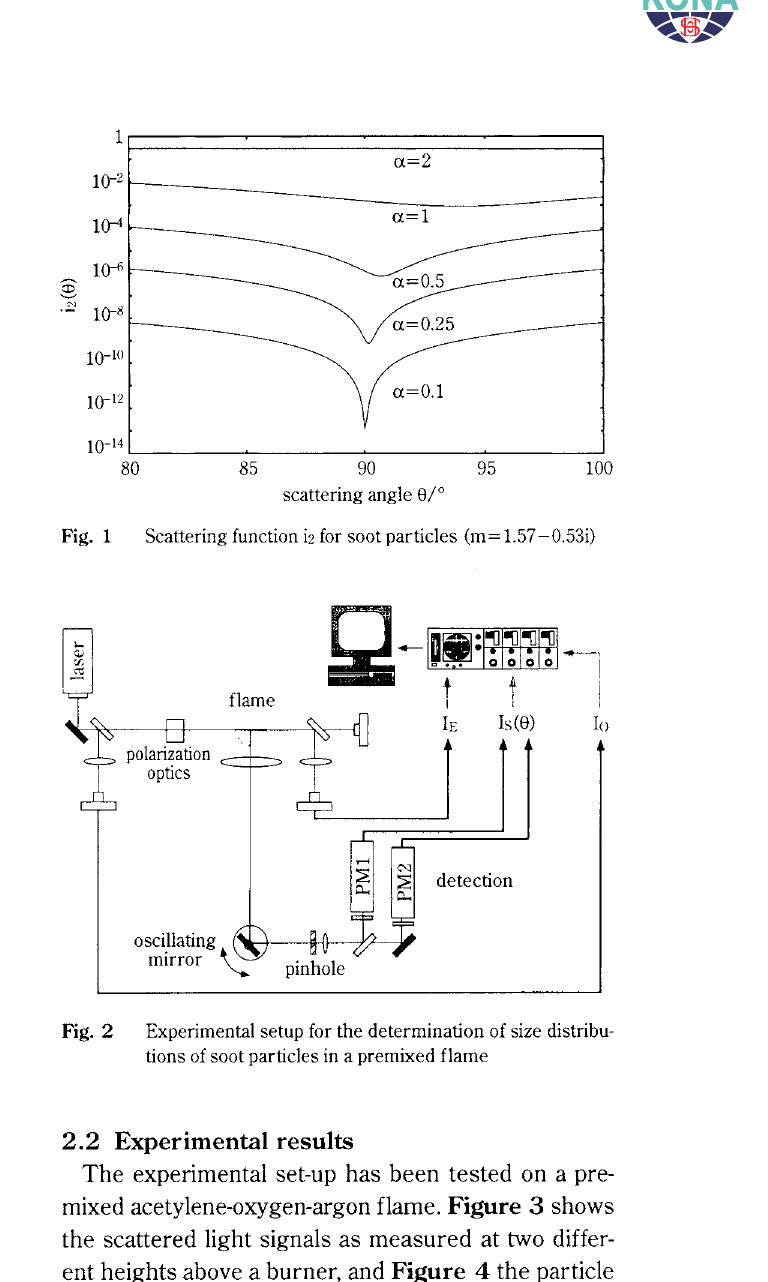
Scattering function i2 for soot particles (m= 1.57 -0.53i)